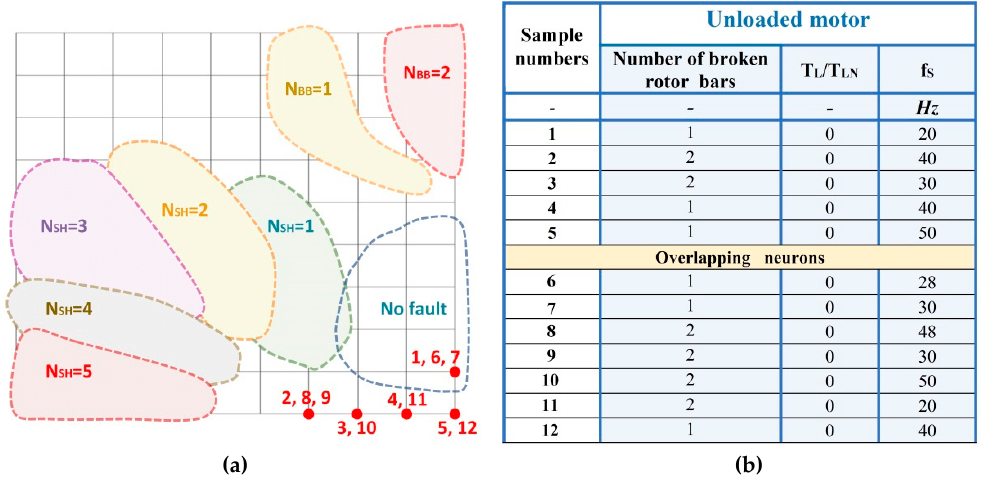
Figure 15. Classification of the rotor failures for no-load operation mode: ( a ) Kohonen map 10 × 10: dotted lines—IM damage categories involved in the classification, hatched areas—IM damage categories not involved in the classification; N sh —number of shorted turns in the stator winding, N bb —number of broken rotor bars; ( b ) specification of test data parameters; T L —load torque, T LN —rated motor torque, f s —frequency of the supply voltage.